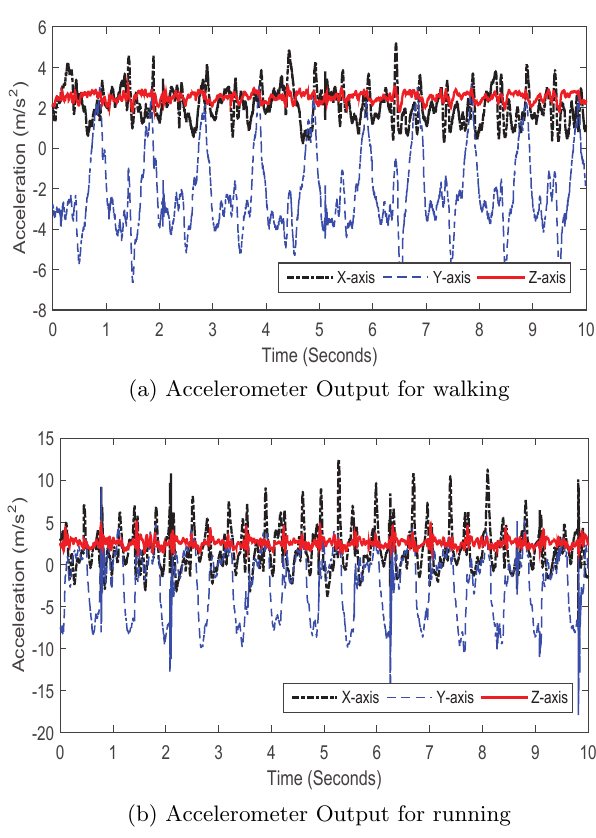
Figure 5: The output signal of the 3-axis accelerom- eter for both walking and running of subject 2.